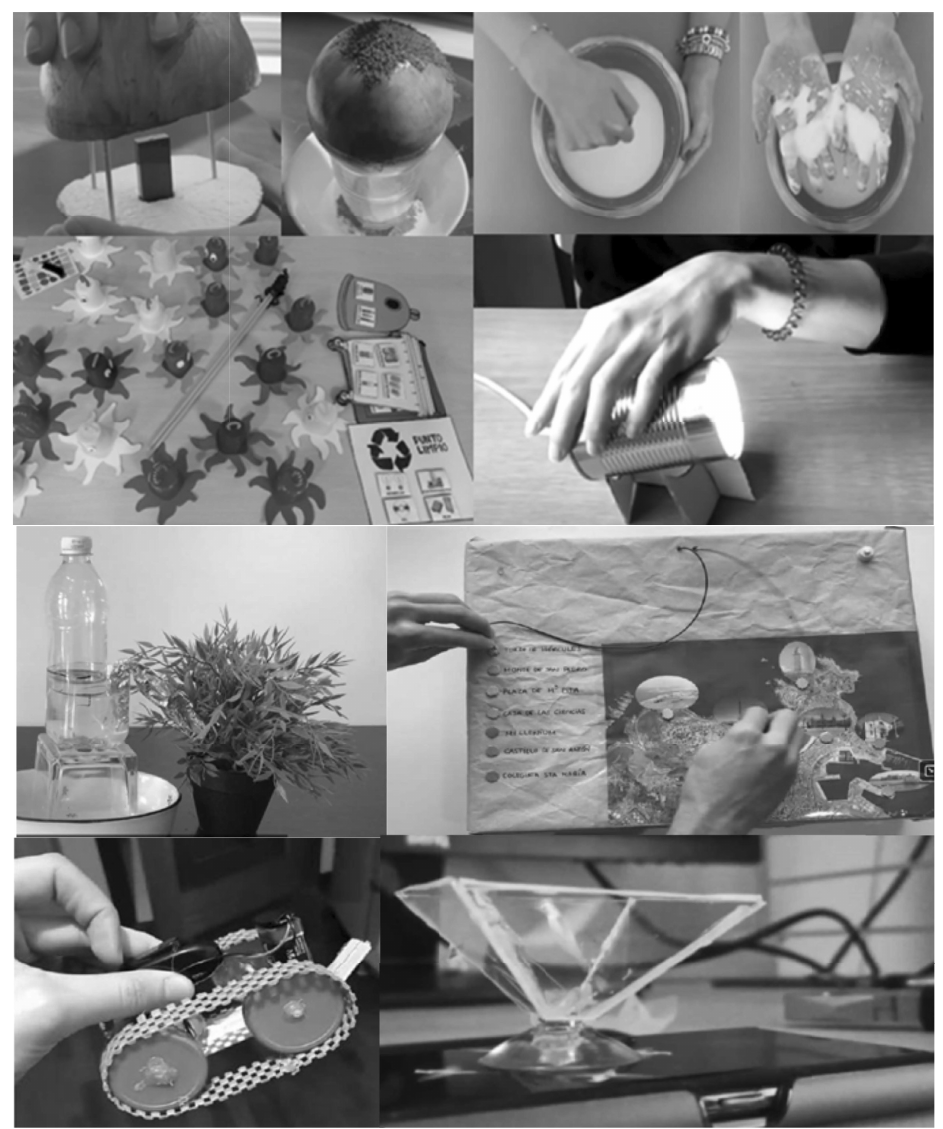
Figure 3. Photos of the projects created by students and developed by